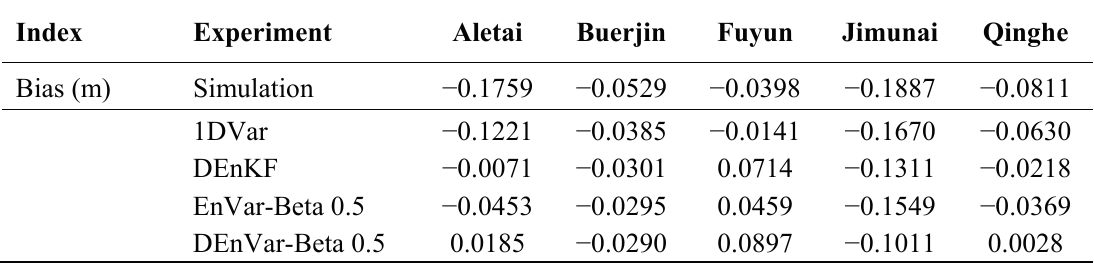
Table 3. Summary of the analyzed SD simulation statistics in 1DVar, DEnKF, EnVar-Beta 0.5, and DEnVar-Beta 0.5 DA experiments at five sites from November 2008 to March